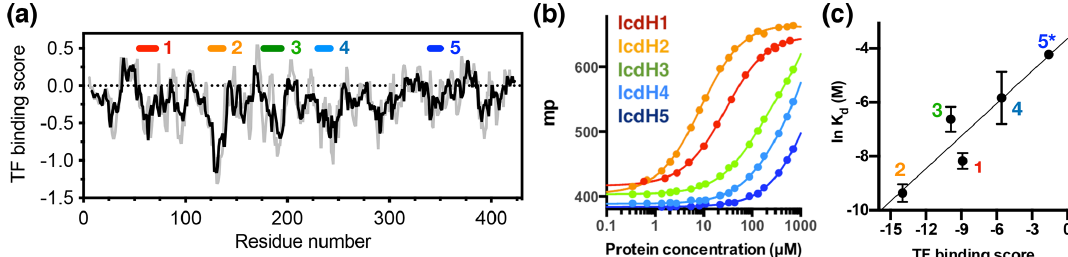
Figure 3. Experimental validation of the scoring function of predicted TF binding motifs. (a) Predicted TF binding score of as a function of residue number of ICDH. Running averages with a window size of 8 and 13 residues are shown in grey and black, respectively. A segment with a predicted binding score of lower than − 0 . 5 is considered a potential binding site. Five peptides were chemically synthesized corresponding to the regions indicated above, numbered from 1 to 5. (b) Fluorescence polarization (FP) analysis of TF binding to the synthetic peptides labeled with FITC. The FP of the peptides IcdH1–5 as a function of TF concentration are colored from red to blue as indicated in inset, which correspond to the segments indicated in (a) . (c) Linear regression of the natural logarithm of the binding constant ( K d ) as a function of the predicted TF binding score. The resulting function is y = 0 . 0856 x + 0 . 772 with R 2 = 0 . 88. The error bars were derived from three technical replicates of the FP analysis. The error of IcdH5 was larger than the mean value, which is omitted in this